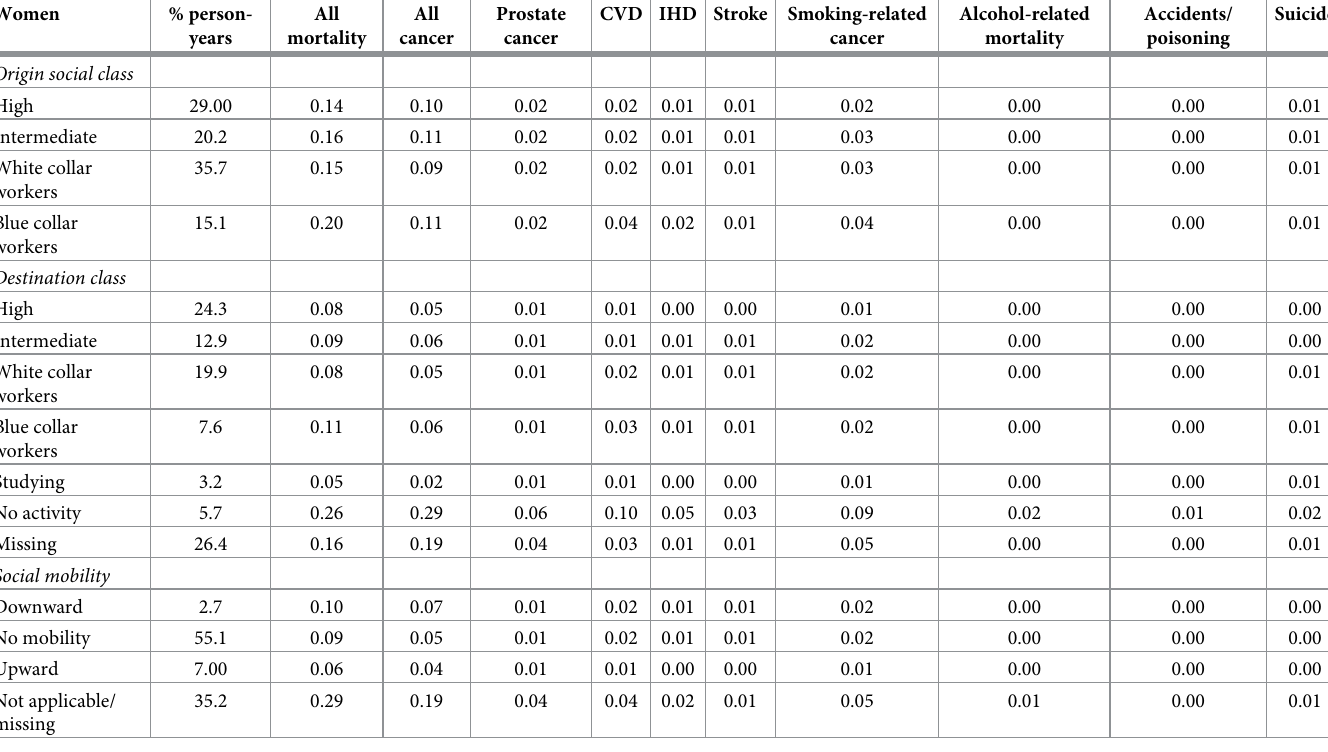
Table 3. Percent of all person-years for women in each status and percent of person-years ending in death by origin-, destination social class and social mobility. Women % person-